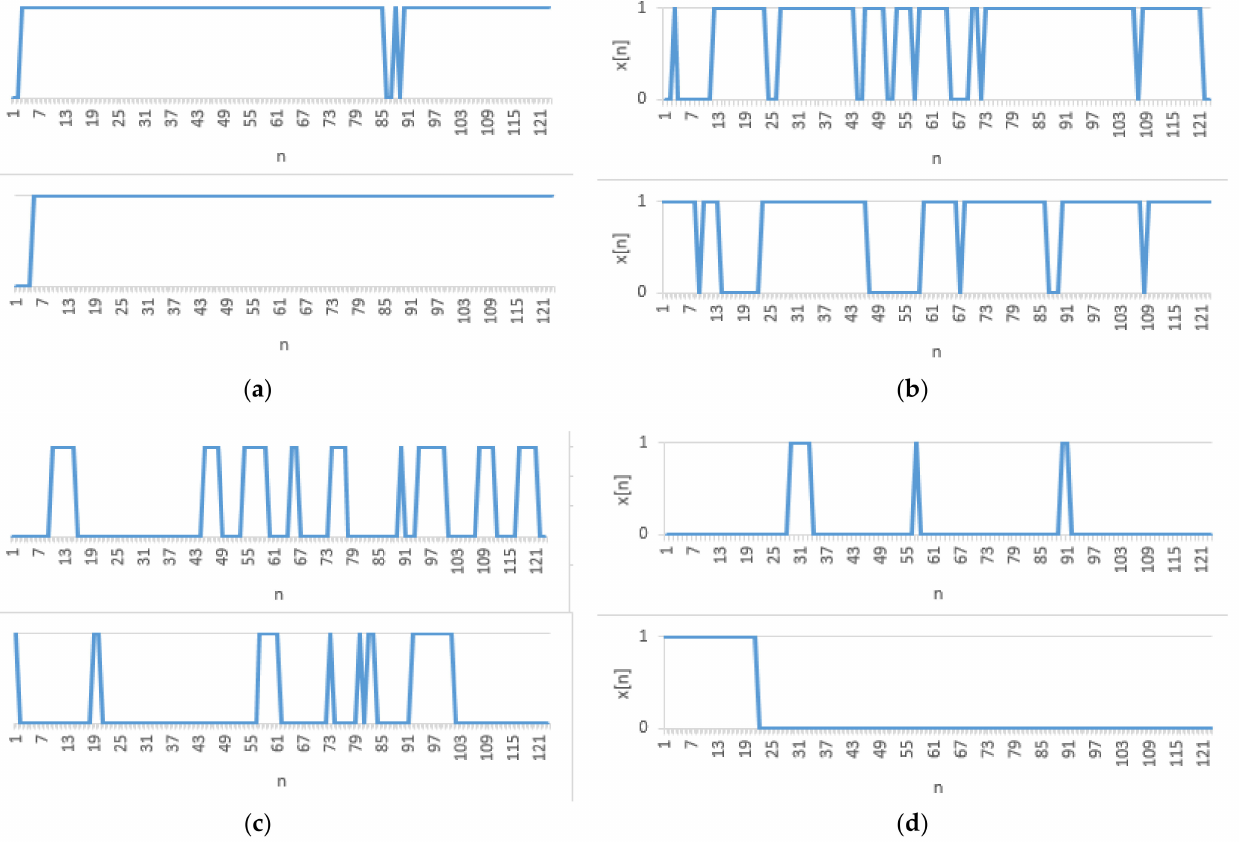
Figure 4. A sample to represent students in: ( a ) Class 1; ( b ) Class 2; ( c ) Class 3; ( d ) Class 4. Class 1 represents the students where they are most attentive, as shown by the high peak of the waveform in Figure 4a. Figure 4b is the sample of class 2 where students are mostly attentive, which is represented by the high peak of the waveform, while the inattentive periods are few, which is represented by the low peak. Figure 4c is the sample of class 3 where students are mostly inattentive, which is represented by the low peak, and have few attentive periods, which is represented by the high peak. Class 4 represents students where the students are mostly inattentive, as shown by the low peak of the waveform in Figure